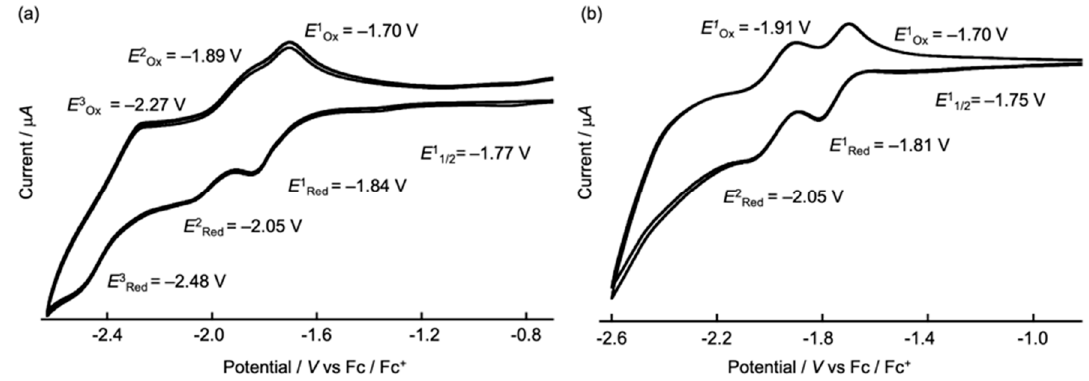
Figure 1. Cyclic voltammetry of 1.0 mM for 1 12 ( a ) and 1 6 ( b ) in a 0.10 M solution of Bu 4 NPF 6 in CH 2 Cl 2 at a scanning rate of 100 mVs –1